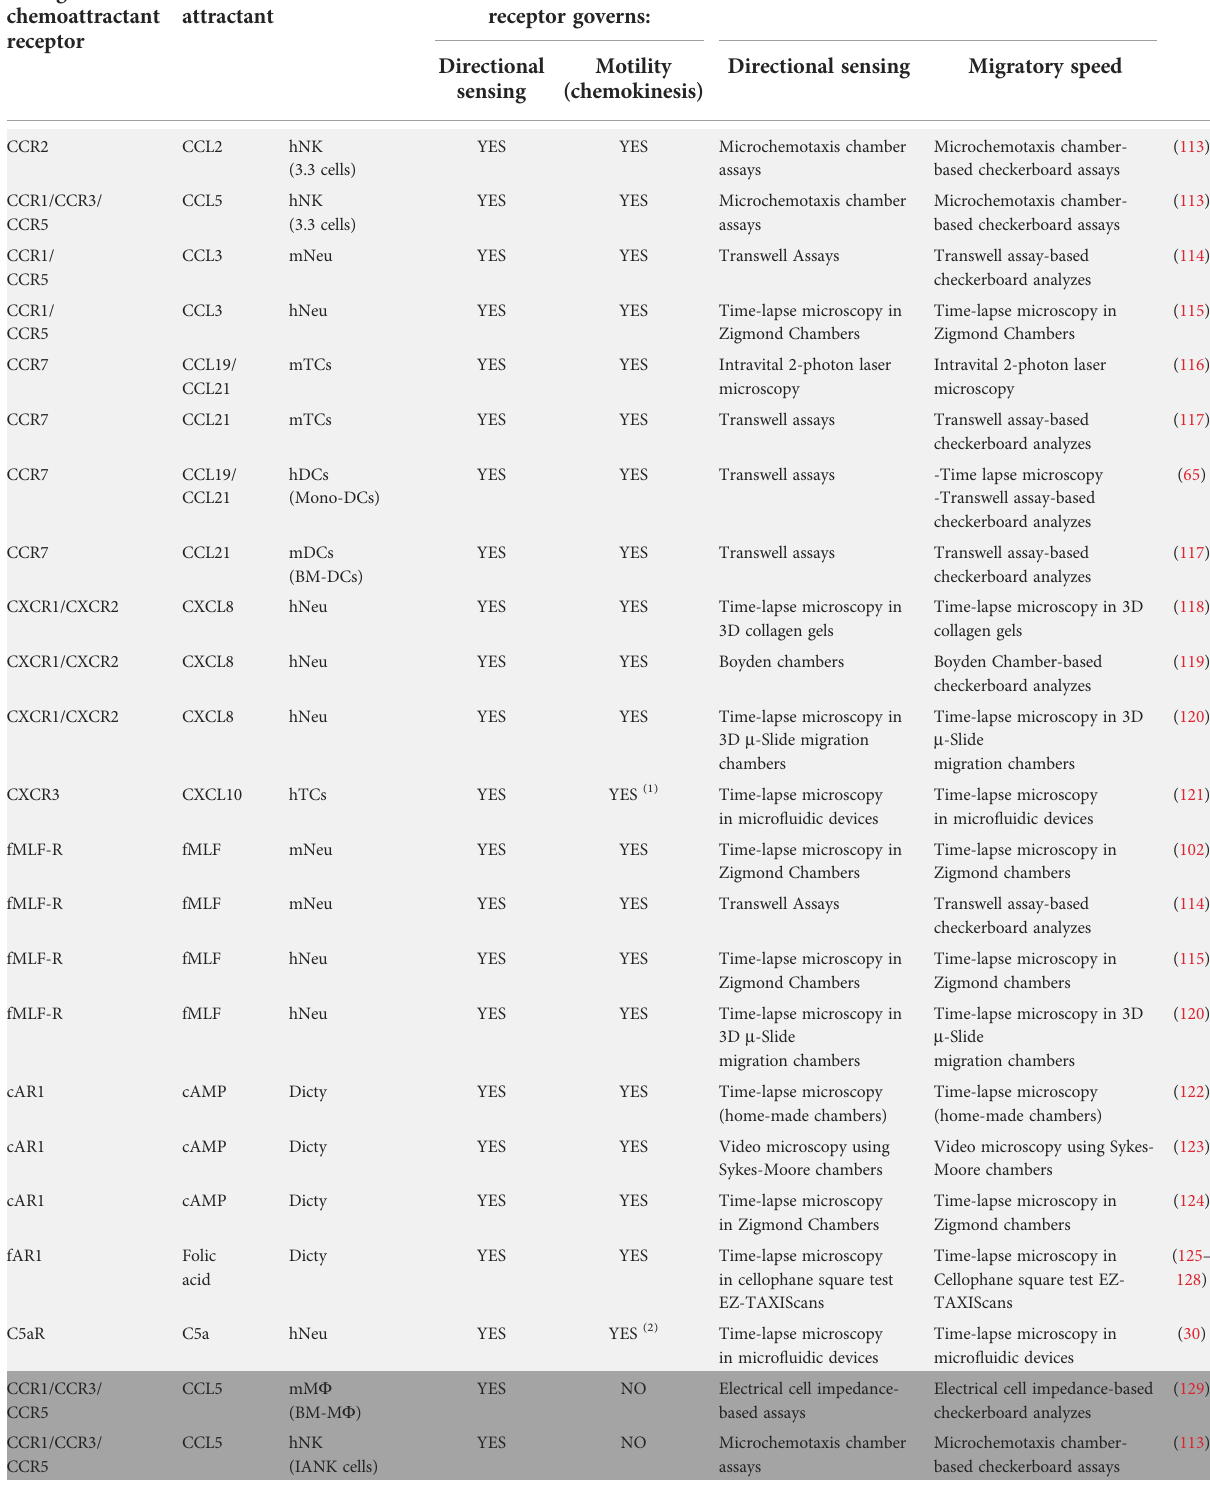
TABLE 2 Ability of endogenous chemoattractant receptors to control chemokinesis In the table are presented endogenous chemoattractant receptors that control directional sensing and chemokinesis (clear grey) or directional sensing, but not chemokinesis (dark grey).